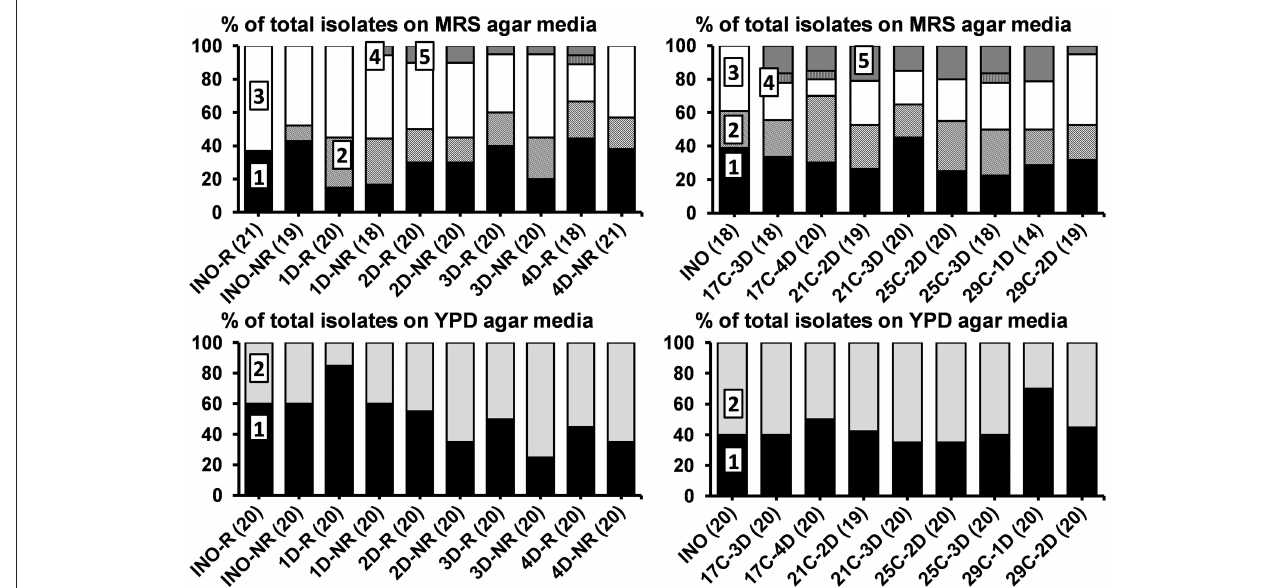
FIGURE 2 | Culture-dependent microbial species diversity of the rinsed (INO-R) and non-rinsed (INO-NR) grain inocula and of the non-rinsed grains of the eight series of water kefir fermentations (21 ◦ C) differing in backslopping time and rinsing of the grains during each backslopping step, at the end of backslopping step 8 (left), as well as of the non-rinsed grain inoculum (INO) and the non-rinsed grains of the eight series of water kefir fermentations differing in incubation temperature and backslopping time, at the end of backslopping step 8 (right). The number of isolates is indicated between brackets. Isolates from MRS agar media: (1) Lacticaseibacillus paracasei (100% identity; GenBank accession no. AP012541); (2) Lentilactobacillus hilgardii (100% identity; accession no. LC064898); (3) Liquorilactobacillus nagelii (99% identity; accession no. NR112754); (4) Liquorilactobacillus mali (99% identity; accession no. NR112691); and (5) Leuconostoc pseudomesenteroides (99% identity; accession no. LC096220). Isolates from YPD agar media: (1) Saccharomyces cerevisiae [LSU (99% identity; accession no. CP011558) and ITS (99% identity; accession no. KC515374)]; and (2) Dekkera bruxellensis [LSU (99% identity; accession no. GU291284) and ITS (99% identity; accession no. FJ545249)]. LSU, large subunit rRNA gene; ITS, internal transcribed spacer. C, temperature (17, 21, 25, or 29 ◦ C); D, days of backslopping (1, 2, 3, or 4); R, rinsed; NR,